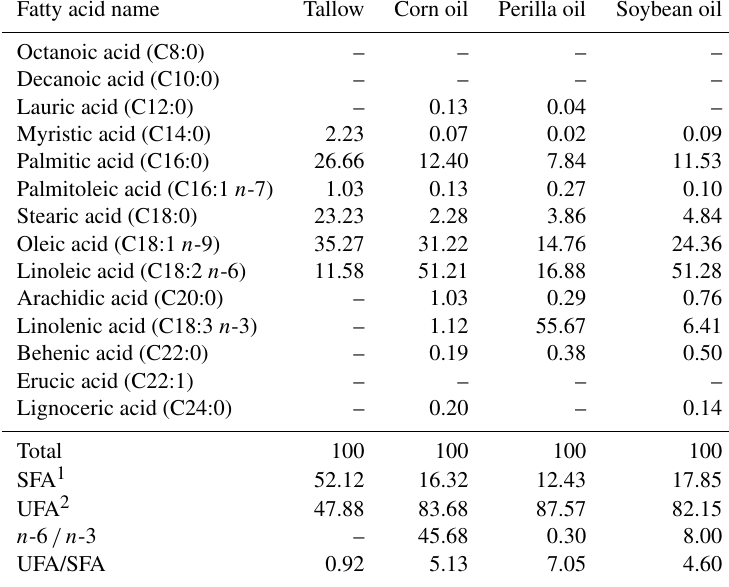
Table 1. Fatty acid composition of the used coconut, perilla, corn, and soybean oil (grams per 100g total fatty acid). Fatty acid